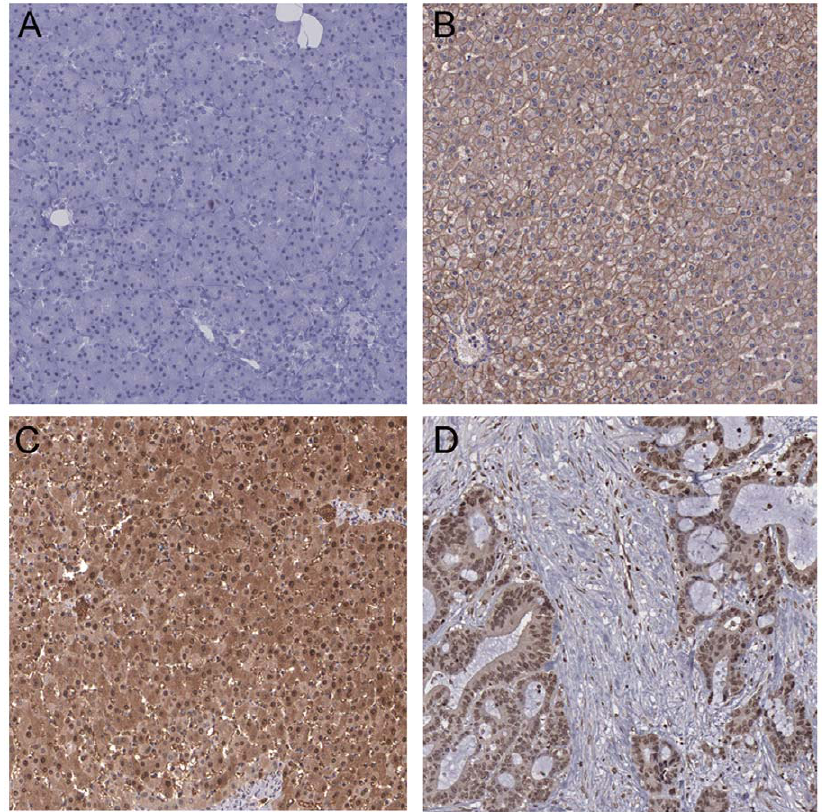
Figure 1. Immunohistochemical analysis of dyskerin protein expression in HCC tissues and noncancerous liver tissues. A. Negative expression of dyskerin in a noncancerous liver sample. B. High expression of dyskerin in a noncancerous liver sample. C & D. High expression of dyskerin in HCC samples.